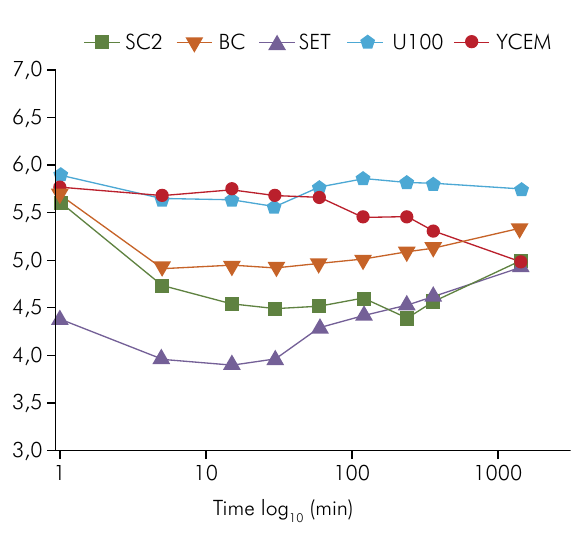
Figure 4. pH value of the eluate over a 24-hour storage period